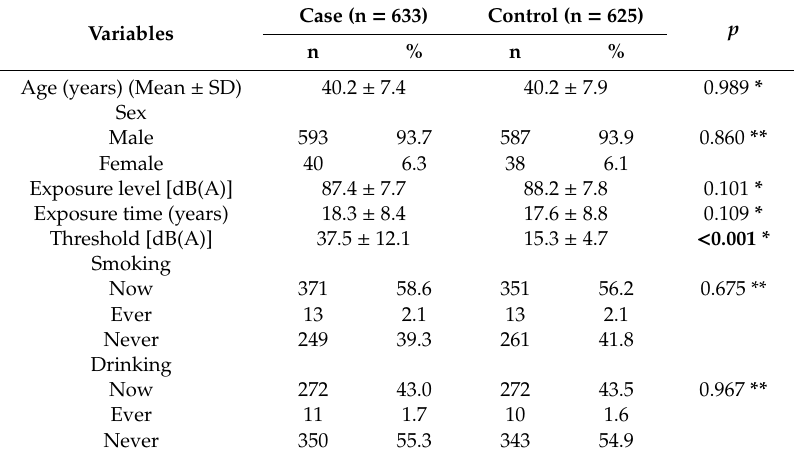
Table 2. Demographic characteristics of the study